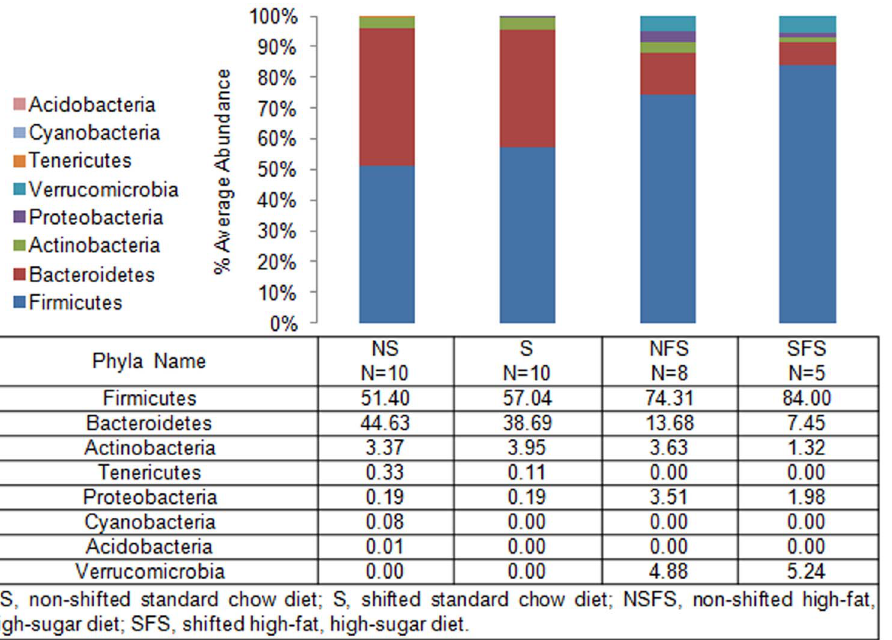
Figure 3. Mouse gut microbial community structure at the phylum level. The bar graph graphically represents the average relative abundance of classified bacteria SSU rRNA gene amplicons belonging to the most abundant phyla.